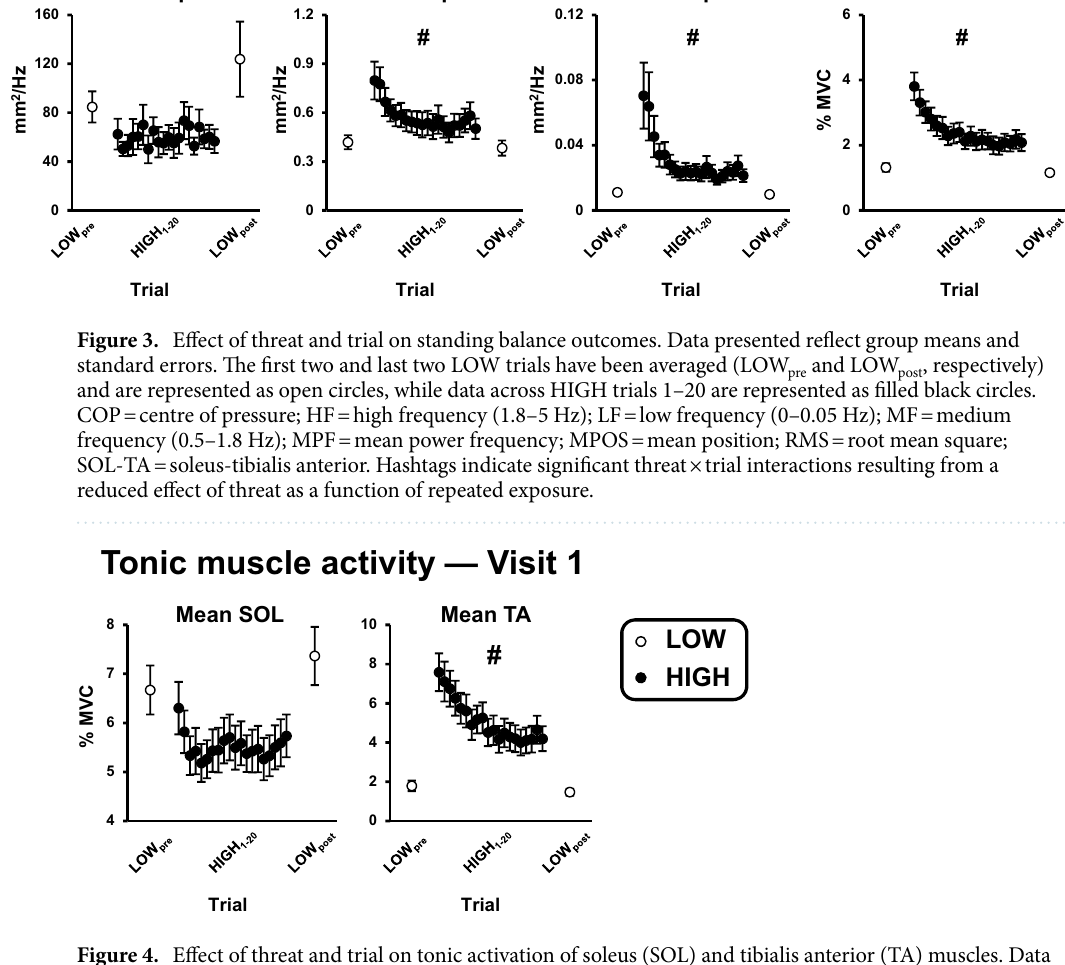
Figure 4. Effect of threat and trial on tonic activation of soleus (SOL) and tibialis anterior (TA) muscles. Data presented reflect group means and standard errors. The first two and last two LOW trials have been averaged (LOW pre and LOW post , respectively) and are represented as open circles, while data across HIGH trials 1–20 are represented as filled black circles. Hashtags indicate significant threat × trial interactions resulting from a reduced effect of threat as a function of repeated